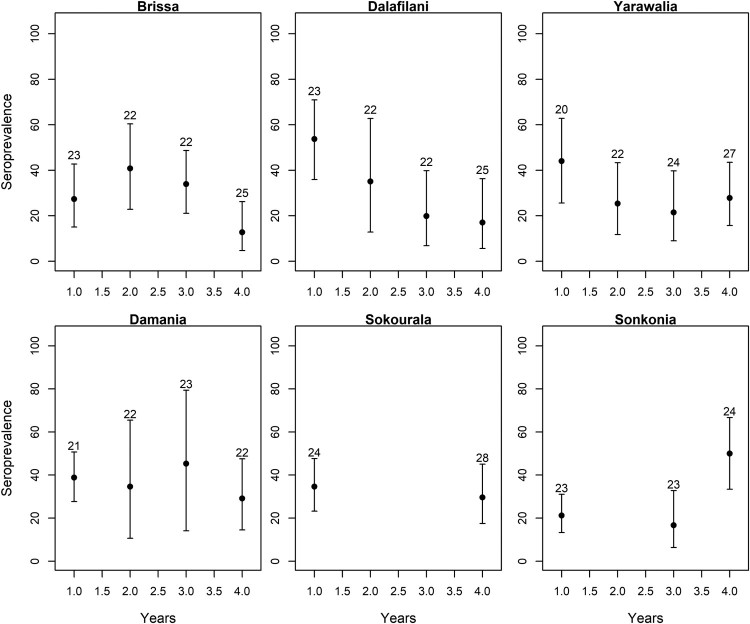
Mean LASV seroprevalence of M. natalensis in the treatment (Brissa, Dalafilani, and Yarawalia) and control (Damania, Sokourala, and Sonkonia) villages over time (years). The seroprevalence was corrected by the mean eye lens weight (number on top of the bars in mg), a known proxy for age in mammals. Bars indicate 95% (binomial) confidence intervals on the mean seroprevalence.